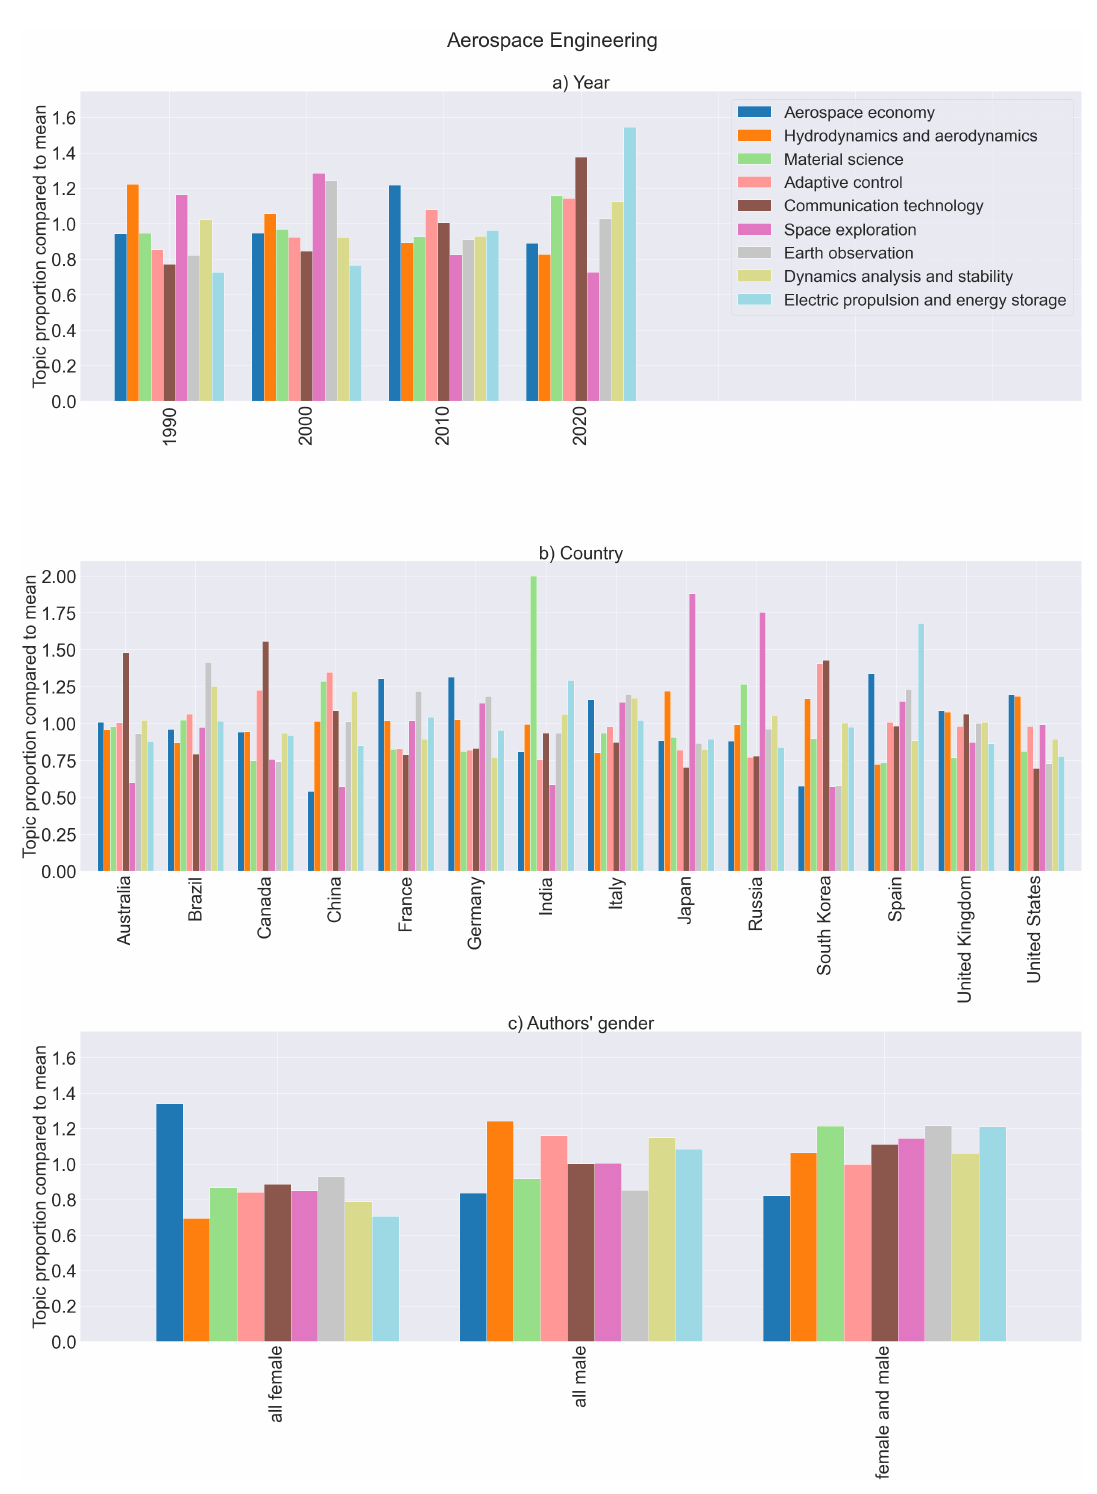
Figure 8. Topic proportion compared to mean, c κ ( ˆ D α ) , for 9 topics of the sub-area aerospace engineering grouped by ( a ) publication year, ( b ) country, and ( c ) authors’ gender. The legend for the topics and their colour codes at the top right corner applies to all three